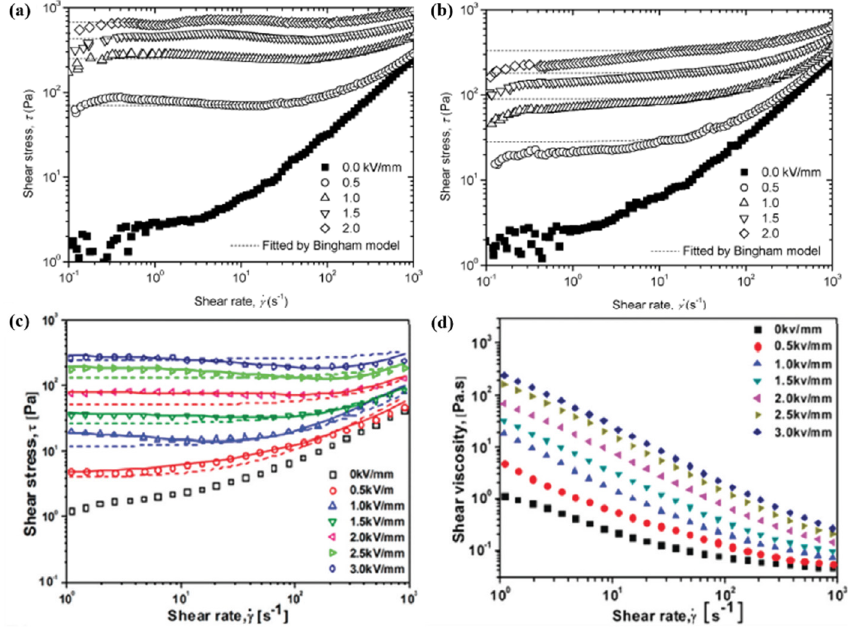
Figure 10. Shear stress of GO / SiO 2 [67] based ER fluid (3 vol.%) under ( a ) DC electric fields and ( b ) AC electric fields (1 kHz), and ( c ) shear stress, ( d ) shear viscosity curves of Si-GO based ER fluid (9 wt.%) [66].